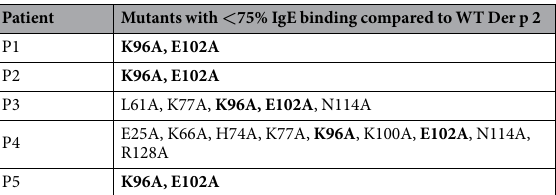
Table 2. Site directed mutants with < 75% IgE binding compared to WT Der p 2 in five selected dust-mite allergic individuals. Mutants in bold showed reduced IgE binding in all allergic individuals tested.